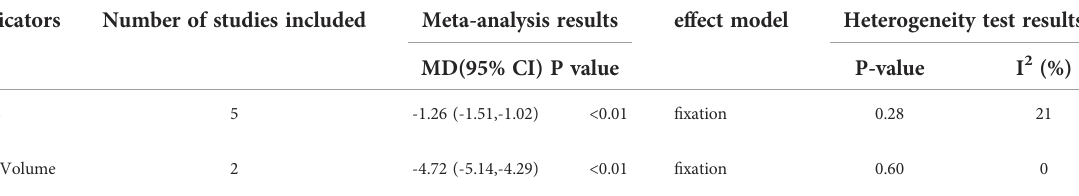
TABLE 2 Meta-analysis results of